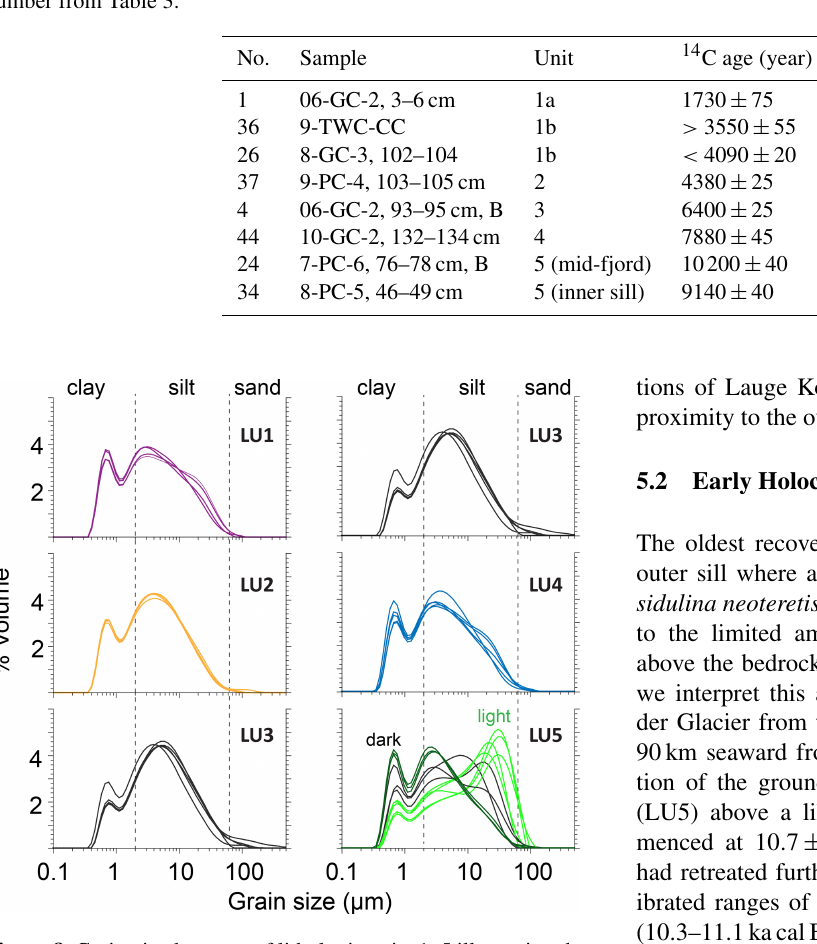
Figure 8. Grain-sized spectra of lithologic units 1–5 illustrating the similar grain size distributions of sediments in LU1 and LU4, as well as the difference between the dark (less dense) and light (more dense) laminations in